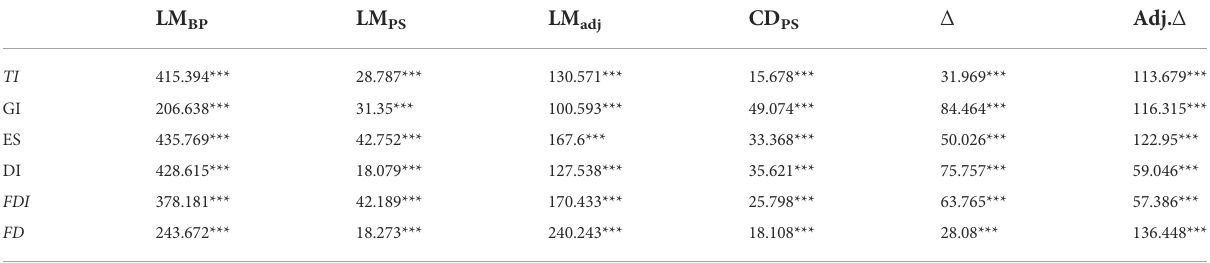
TABLE 1 Results of cross-sectional dependency and homogeneity test.